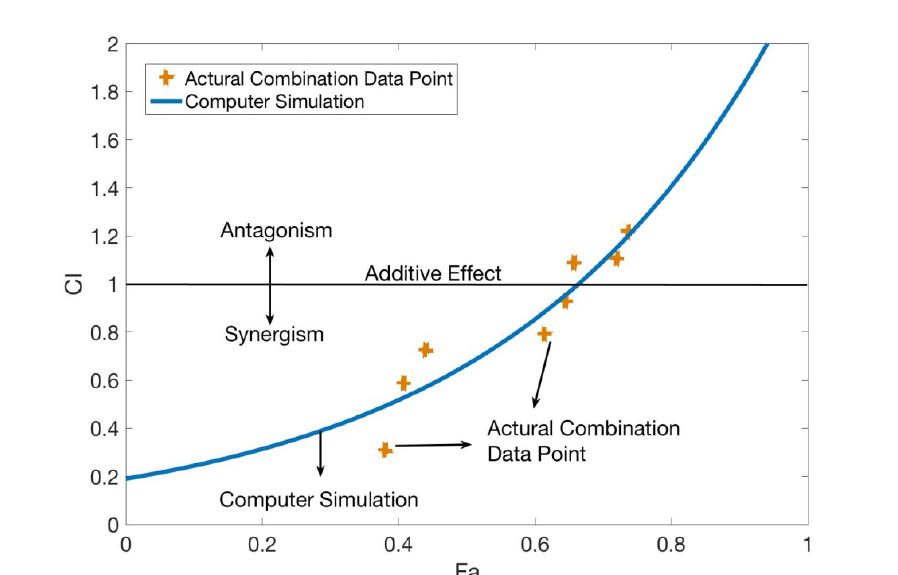
FIGURE 5 - The Fa-CI plot when the ratio of SAA and HSYA is